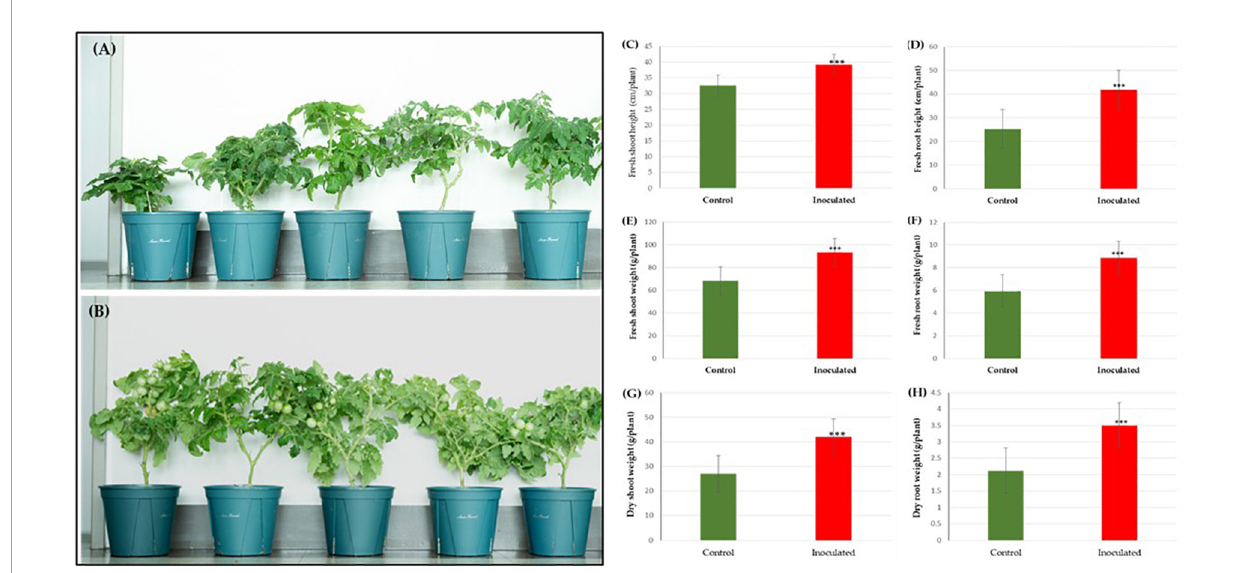
FIGURE2 Effects of Paraburkholderia sp. RG36 T inoculation on the growth of tomato seedlings after 60 days of incubation. Representative images of seedlings growing on control (A) and inoculated pots in green house (B) . On average, fresh shoot height (C) , fresh root height (D) , fresh shoot